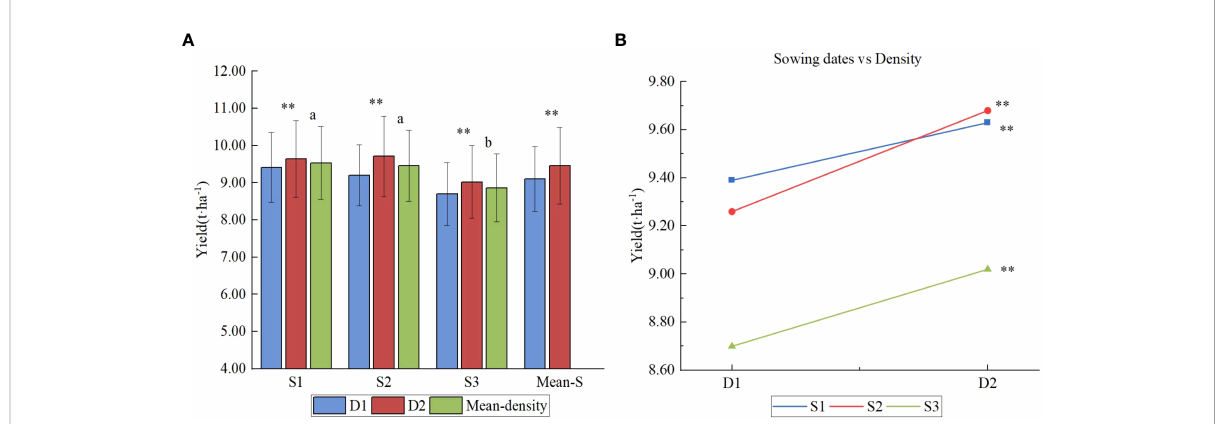
FIGURE 5 Yield effects of different sowing period and densities. (A) Yield of different sowing dates under two densities; (B) Interaction of sowing dates and density. Letters a and b are used to label the difference signi fi cance at 0.05; the same letter means not signi fi cant (NS) among the three sowing dates; ** means highly signi fi cant at 0.01 between the two